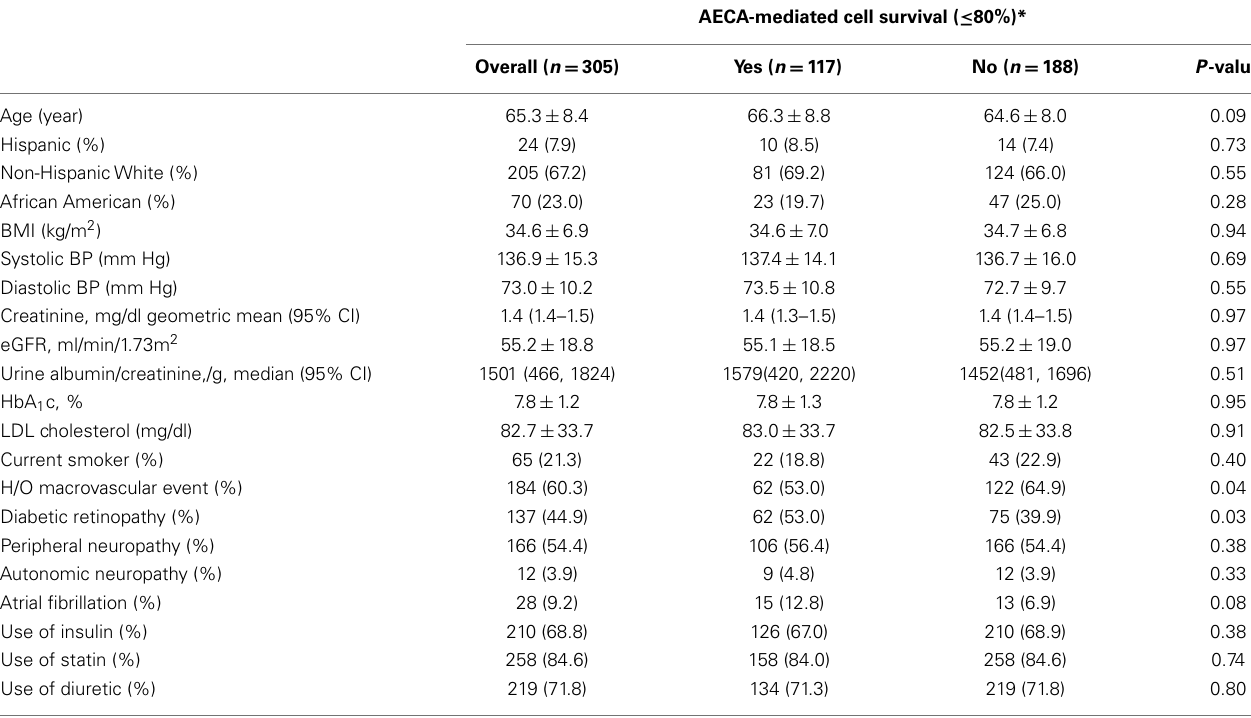
Table 1 | Participant characteristics at baseline by anti-endothelial cell antibody-mediated cell survival group